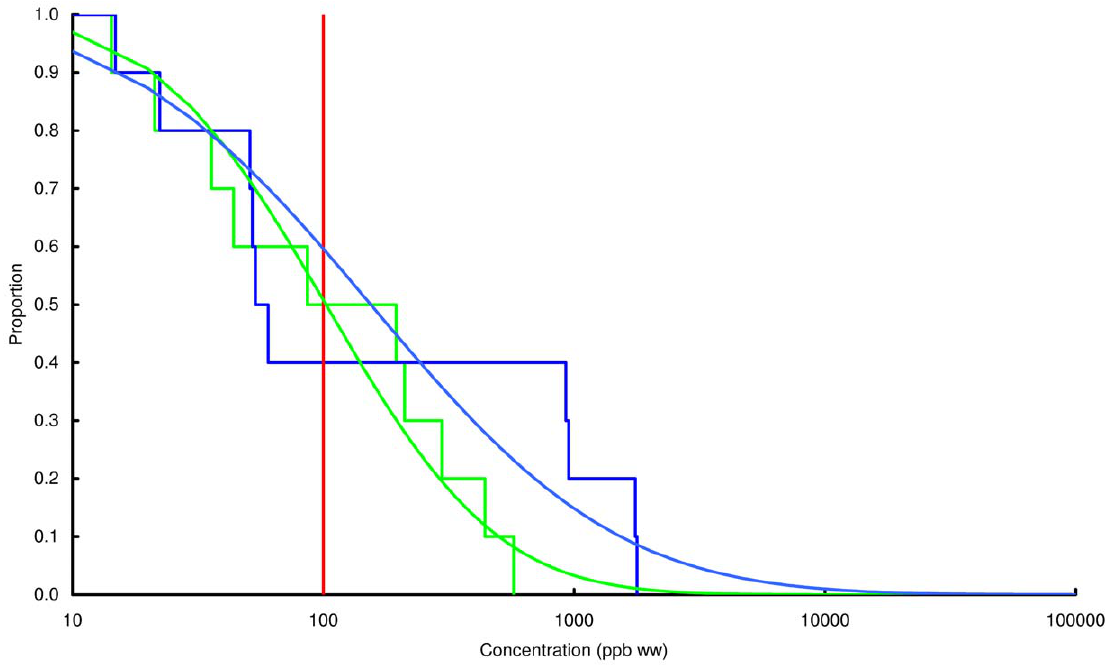
Figure 3. Exceedance distribution of lead concentrations in red grouse. Observed (stepped line) and fitted (curve) exceedance distribution of lead concentrations (ppb wet weight) in red grouse cooked using acidic (green) and non-acidic (blue) methods. The curves represent lognormal distributions fitted to all the data, including those below the limit of quantification, by a maximum-likelihood method involving left-censoring at the LOD/LOQ. The red vertical line shows the statutory maximum residue level (MRL) for poultry and other non-game meat.